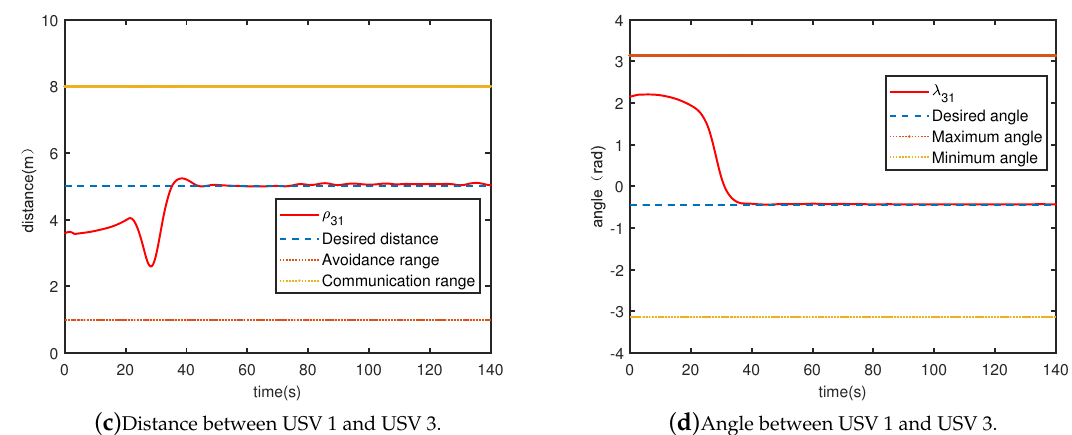
( c ) Distance between USV 1 and USV 3. ( d ) Angle between USV 1 and USV 3. Figure 4. Distance and angle between the leader and USV 1, USV 1 and USV 3.